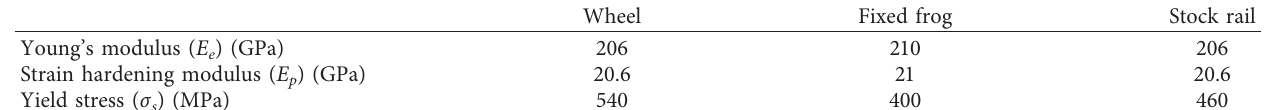
Table 2: The values of wheel-rail Young’s modulus, kinetic hardening modulus, and yield stress.